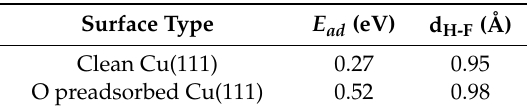
Table 4. Geometrical parameters and adsorption energies of HF molecule on clean and O atom preadsorbed Cu(111)